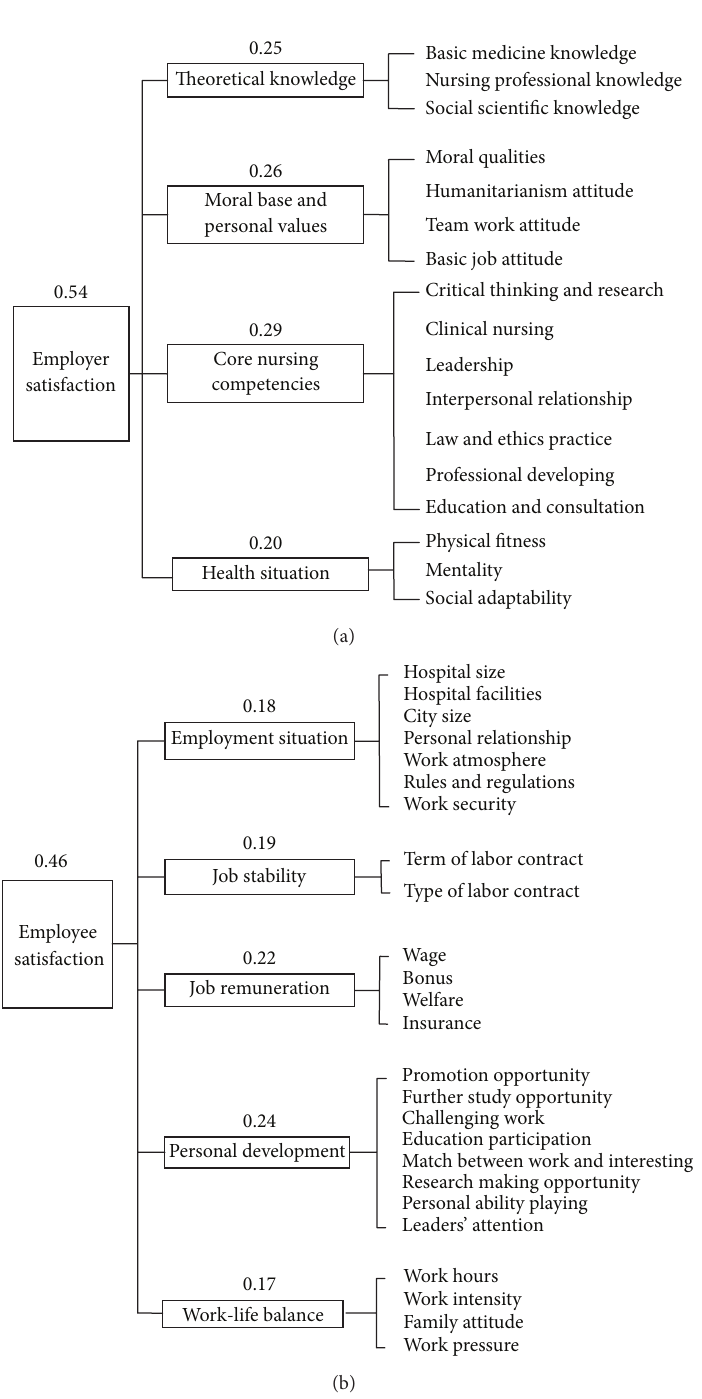
Figure 2: (a) The tool for employer satisfaction. (b) The tool for employee